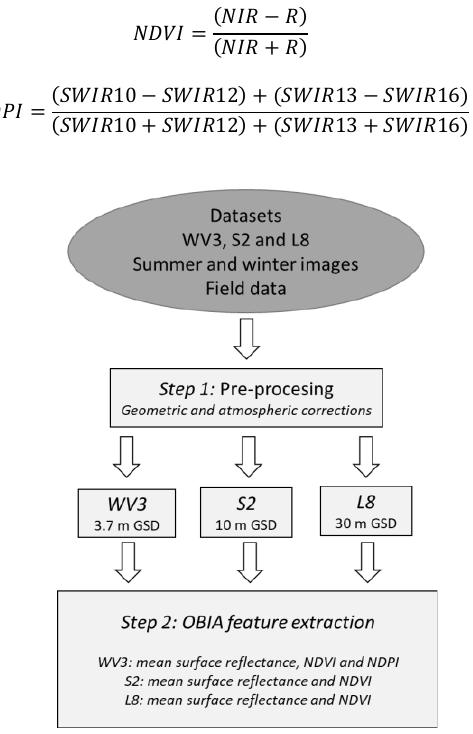
Figure 4 . Flowchart of the methodology applied in this work.